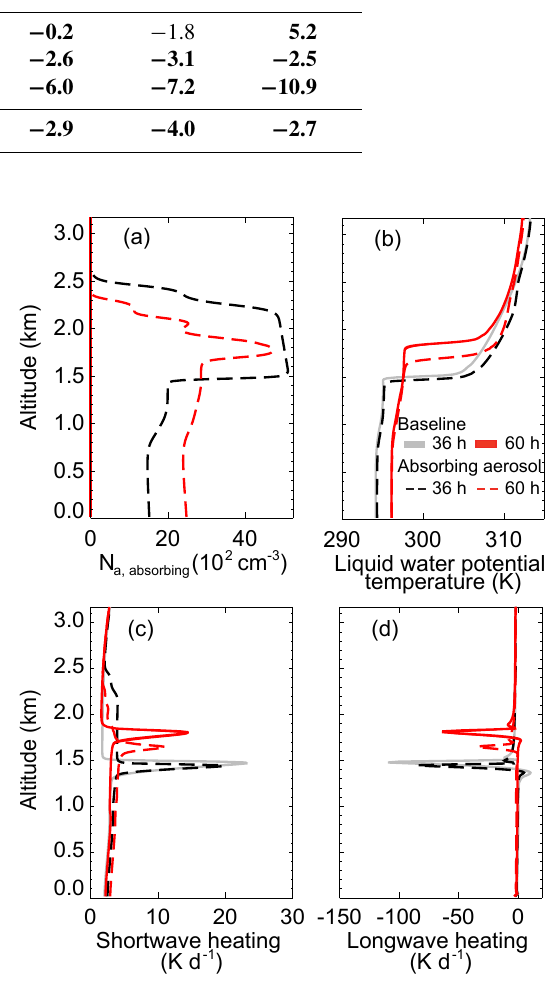
Figure 3. Horizontally averaged profiles of (a) the number concen- tration of absorbing aerosol, (b) liquid water potential temperature, (c) SW heating rate, and (d) LW heating rate at the 36th hour (gray solid line) and the 60th hour (red solid line) for the lightly drizzling baseline ensemble ( N a , sulfate = 150mg − 1 ) and with overlying ab- sorbing aerosol (dashed